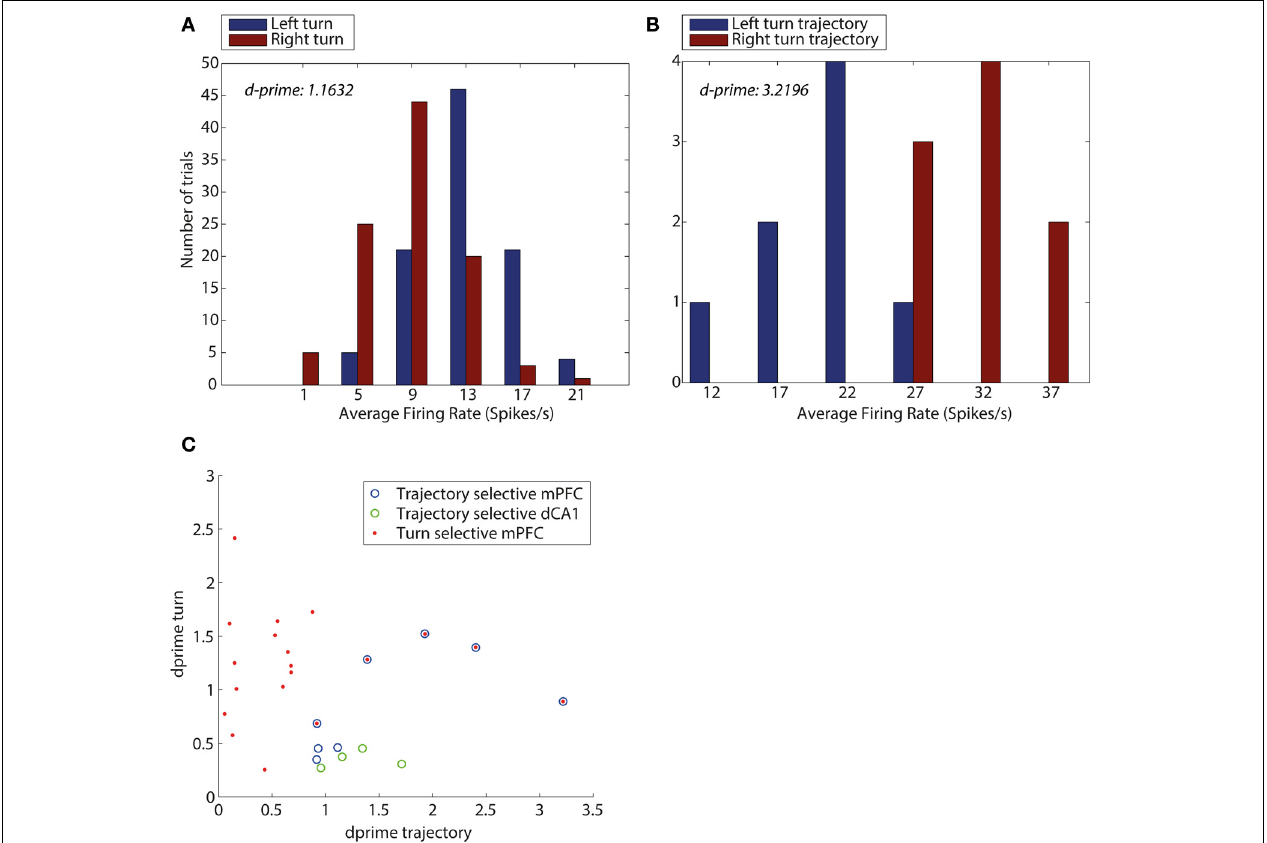
FIGURE 5 | D-prime values for turn direction and trajectory reveal an overlap between mPFC neurons encoding turn and trajectory. (A) D-prime score for a mPFC turn selective neuron, measuring separation of distributions of average firing rates (spikes/s), during left turns (blue) and right turns (red). (B) D-prime score for a mPFC trajectory selective neuron during trajectories making a left turn into the central arm (blue) and trajectories making a right turn into the central arm (red). D-prime values of 1.1632 and 3.2196 (left to right), plots correspond to two mPFC neurons shown in panel (C) . (C) D-prime values for mPFC and dCA1 neurons